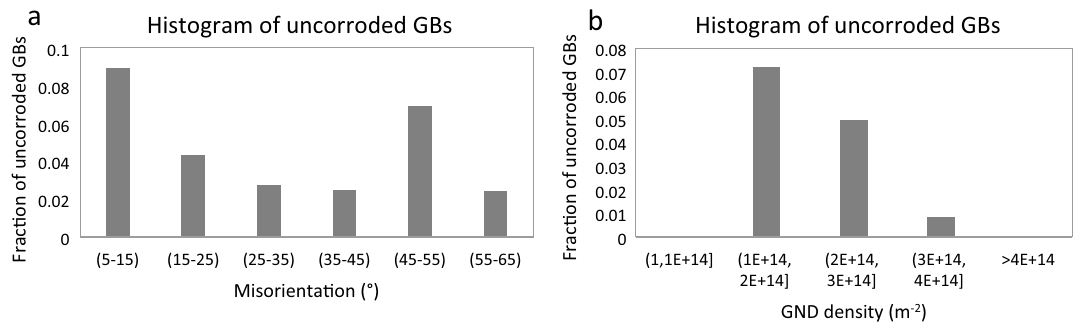
Figure 5. Normalized histogram plots of corroded grain boundaries with ( a ) misorientation angle and ( b ) GND density, after 2400 s of acid exposure (the average GND density around all the grain boundaries is 2.3 × 10 14 m −2